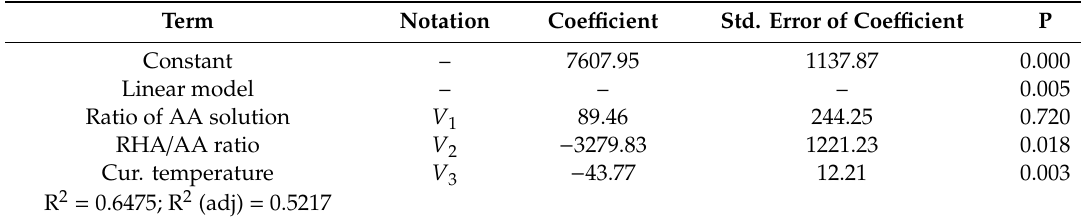
Table 8. Regression analysis of flexural modulus.